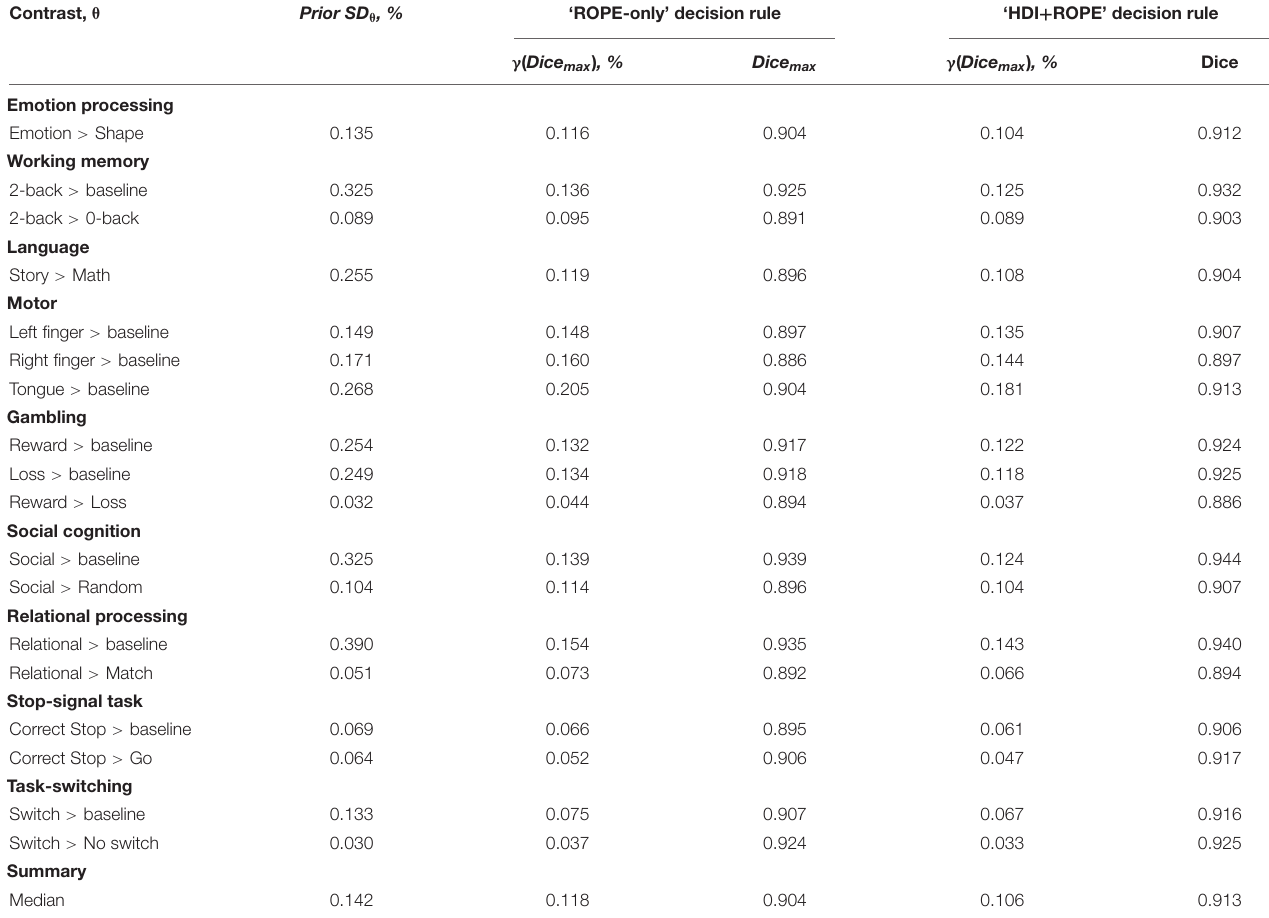
TABLE 1 | Maximum Dice coefficient and corresponding effect size thresholds for each task. Contrast, θ Prior SD θ , % ‘ROPE-only’ decision rule ‘HDI + ROPE’ decision rule γ ( Dice max ) , %